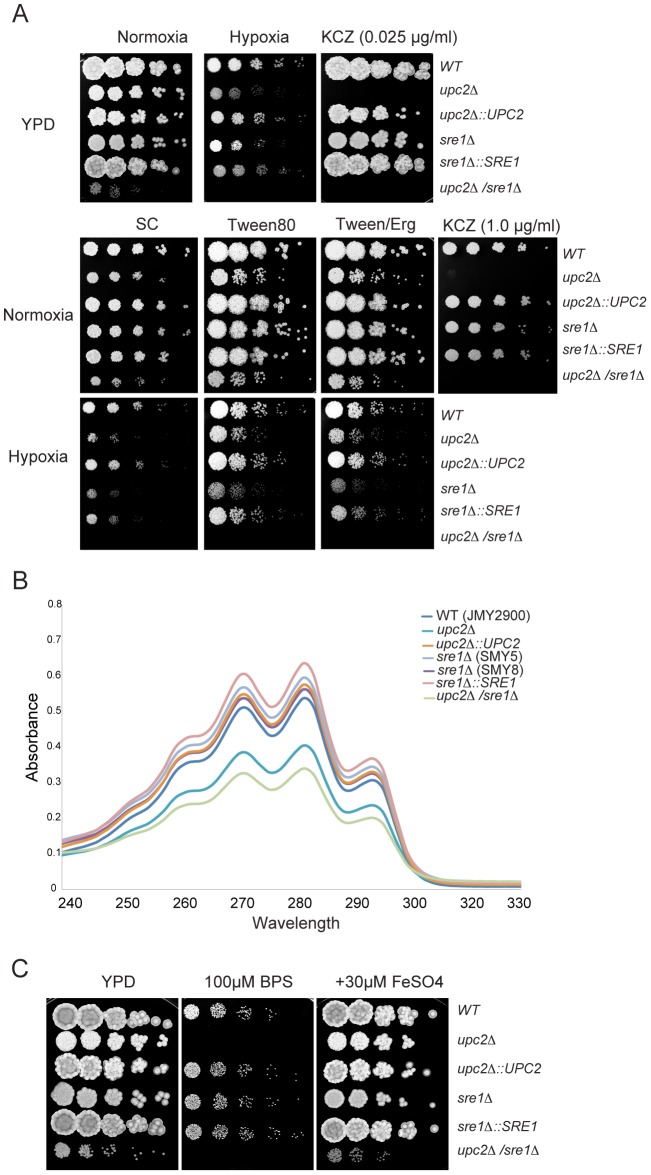
Role of YlUpc2 and YlSre1 in hypoxic growth, drug resistance and iron uptake.(A) YlUPC2 controls susceptibility to azole drugs. YlUPC2 and YlSRE1 were deleted as described in Figure S2, and the deletion and re-constituted strains were plated as serial dilutions on YPD or synthetic complete (SC) media with additions as noted, and incubated in normoxic or hypoxic (1% O2) conditions. Deleting YlUPC2 reduces growth in the presence of ketoconazole on YPD and SC media. Deleting YlUPC2 or YlSRE1 reduces growth in hypoxia, particularly on SC media. The strains shown are (in order): JMY2900, SMY2, SMY6, SMY5, SMY7 and SMY4. (B) Deleting YlUPC2 reduces sterol content. The strains were grown in defined synthetic media and sterol levels were measured by absorbance as described in methods. The strains are the same as in (A), except that two independent deletions of YlSRE1 were tested. The difference between the Ylupc2 deletion and the wild type is statistically significant (P-value<0.05). (C) YlUPC2 is required for iron uptake. The strains listed in (A) were spotted as serial dilutions on YPD, YPD +BPS and YPD+BPS+ additional iron.